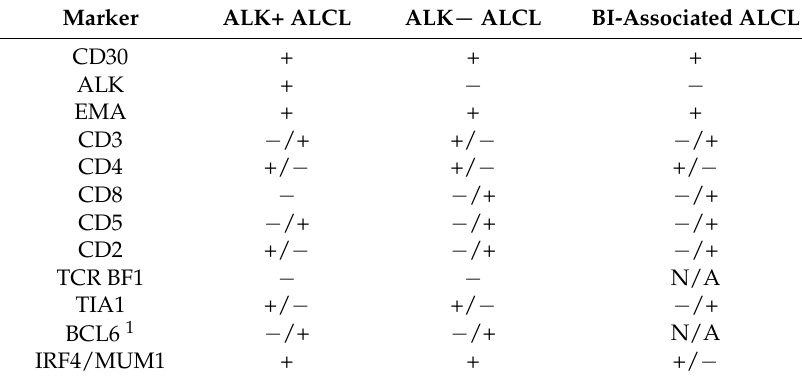
Table 2. Immunophenotypic features of